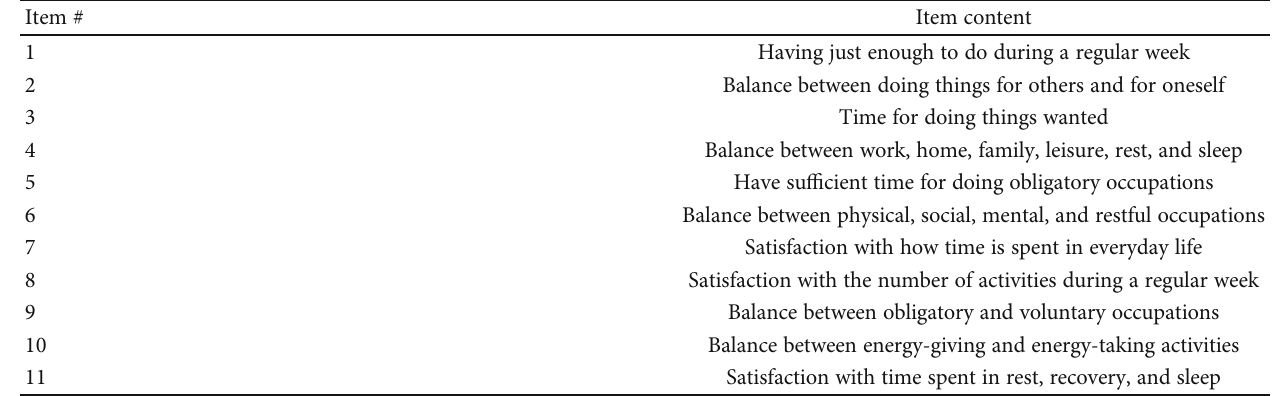
Table 2: Content of items of the